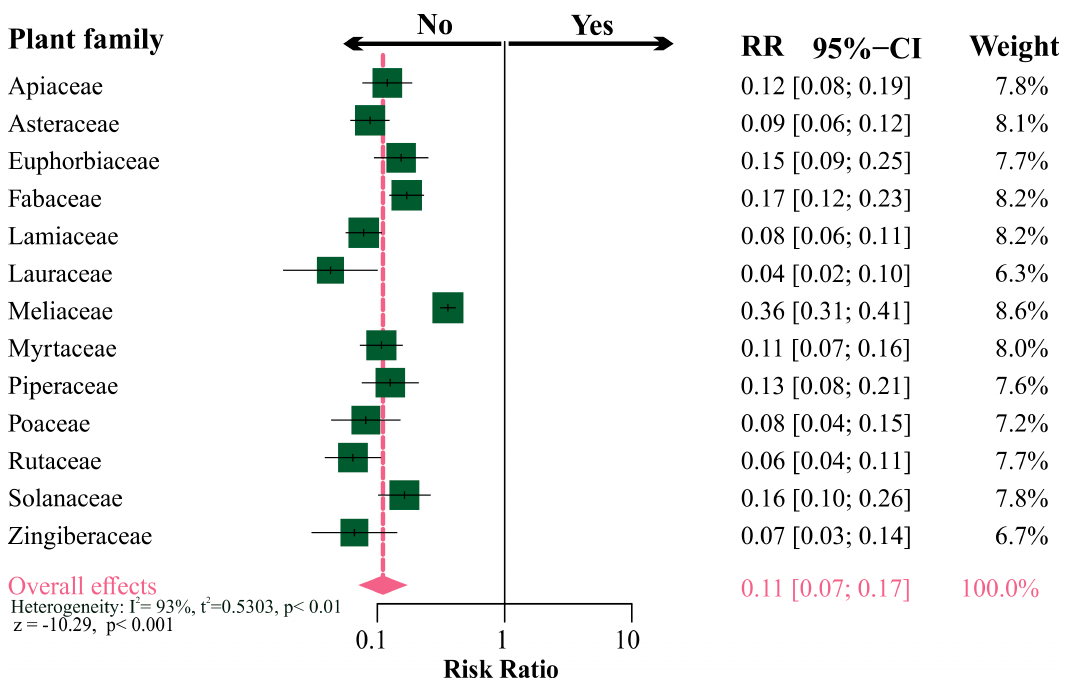
Figure 5. Forest plot summarizing the results from a meta-analysis on the incidence of studies on non-target organisms subjected to botanical insecticides from di ff erent plant families. The risk ratio by plant family (95% CIs) is indicated by dark green squares (horizontal black lines). The combined risk ratio estimate for all botanical families is represented by a pink diamond, where diamond width corresponds to 95% CI bounds. The vertical full-line represents lack of e ff ect or bias (RR = 1). The P -values for the random-model and heterogeneity test of risk ratio by plant family are